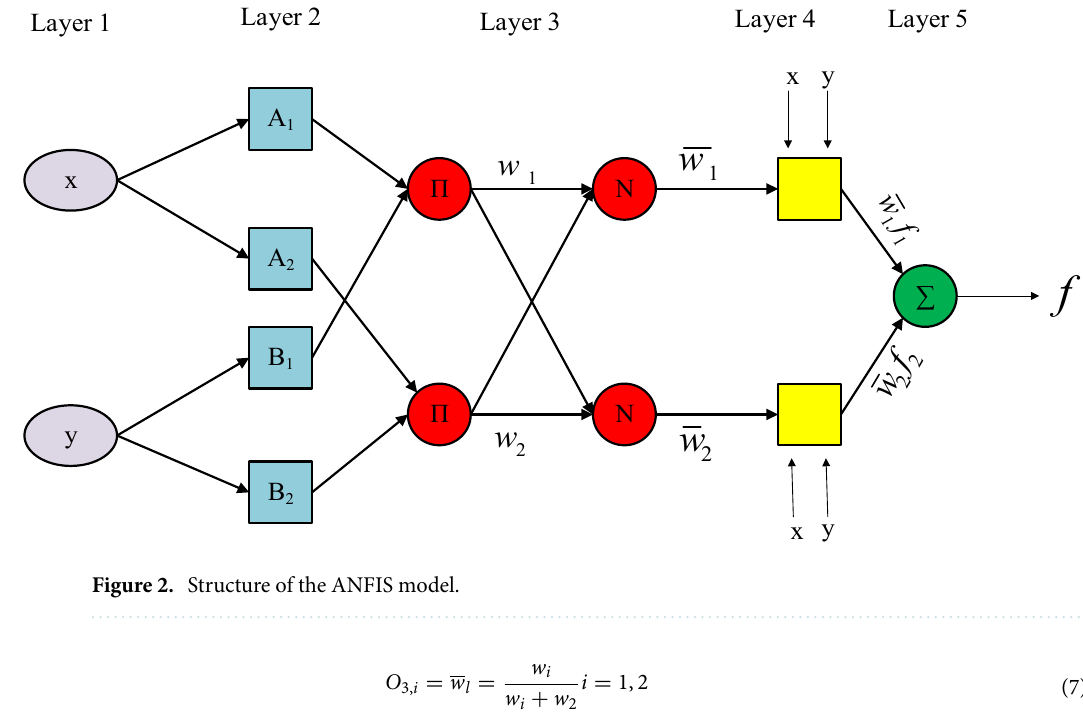
Figure 2. Structure of the ANFIS